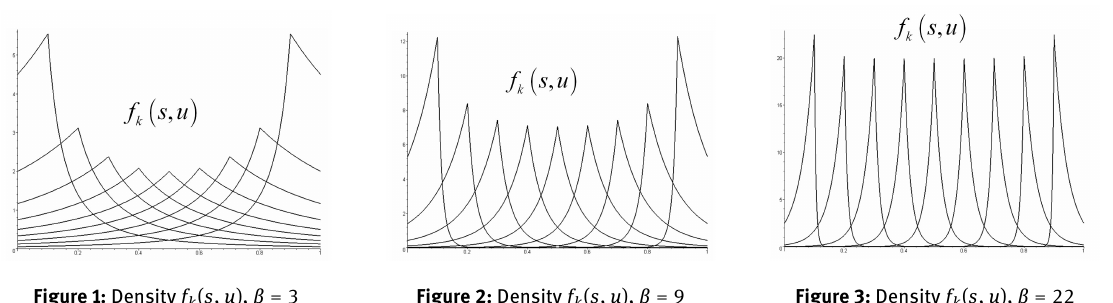
Figure 1: Density f k ( s , u ) , β = 3 Figure 2: Density f k ( s , u ) , β = 9 Figure 3: Density f k ( s , u ) , β =